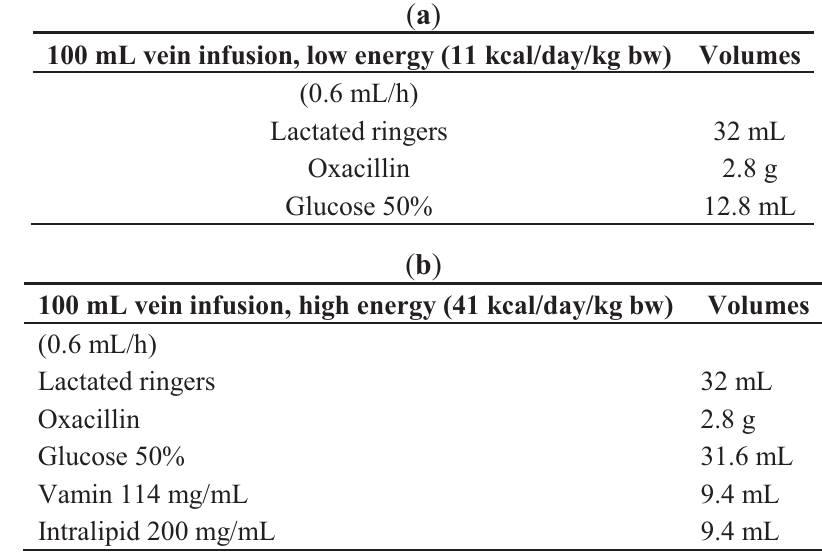
Table 1. Detailed nutritional information : Low Caloric Intake. The appropriate intra- venous solution was administered. The total caloric intake was calculated to be approximately 11 kcal per day. ( a ) Example for a 300 g rat. ( b ) Detailed nutritional information: Eucaloric Intake: Corresponds to 41 kcal per day, for a 300 g rat; administered with an intra-venous solution with an increased nutritional